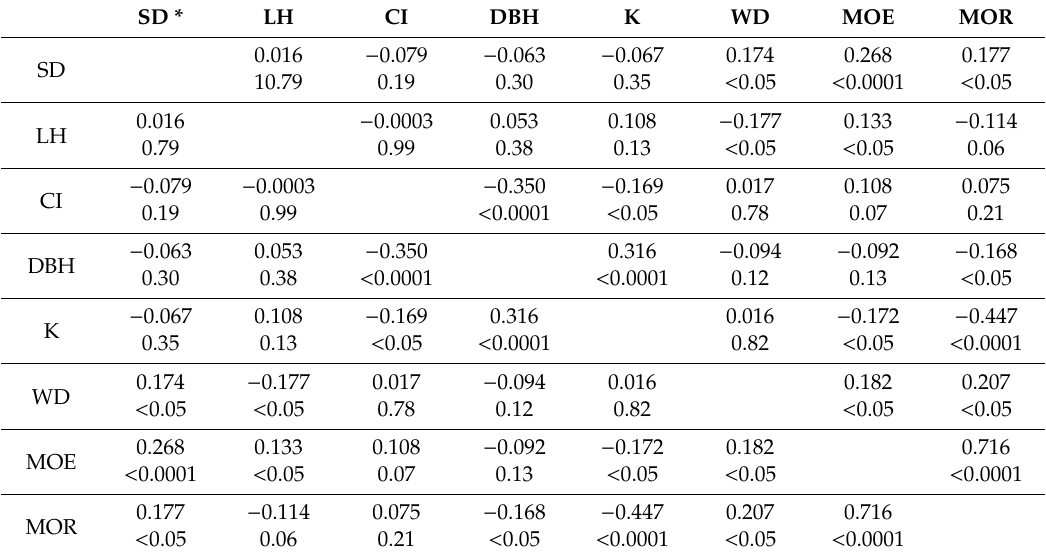
Table 4. Correlation coe ffi cients and probability (in the line below) among tree characteristics and wood quality parameters for the model Scots pine trees, n =